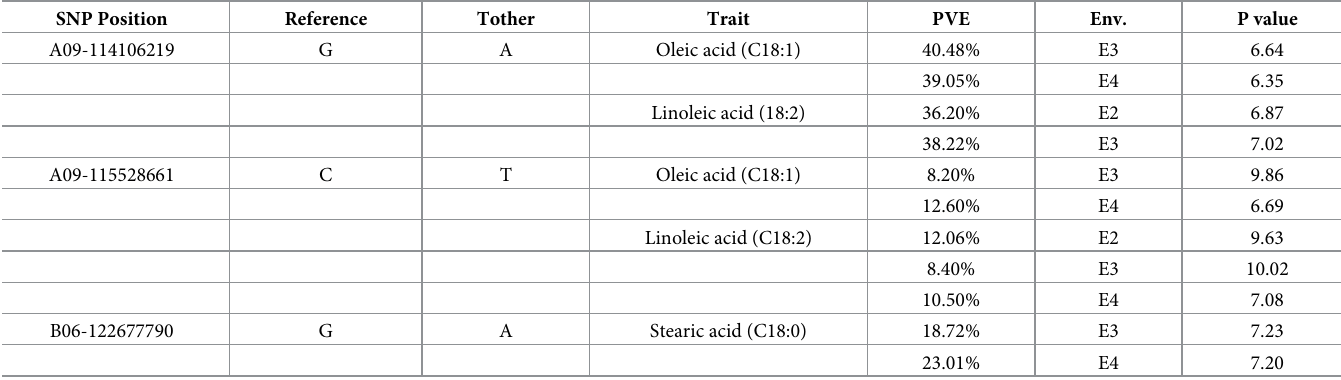
Table 3. The major associated loci identified in multiple